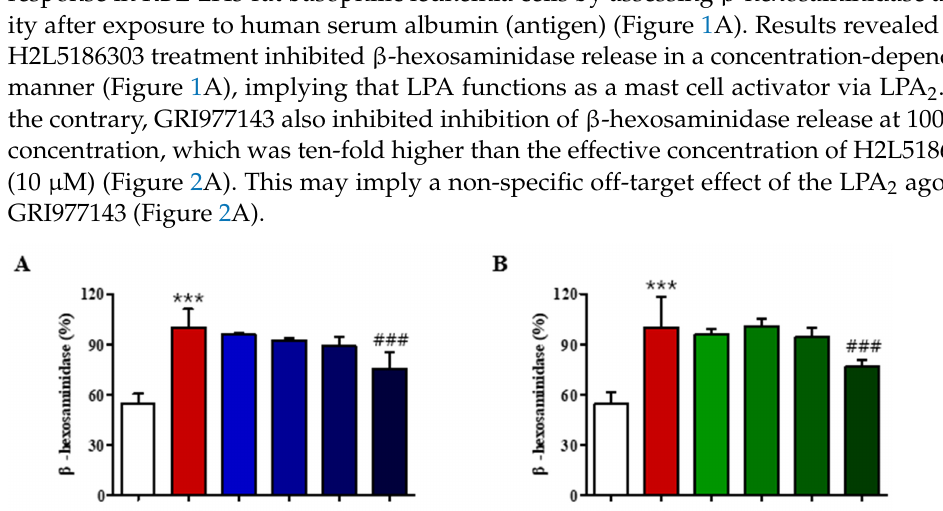
Figure 2. H2L5186303 and GRI977143 inhibit ovalbumin ‐ induced immune cell accumulation in BALF. ( A ) Mice were sensitized with ovalbumin (OVA) twice via intraperitoneal injection on days 0 (D0) and 14 (D14) and challenged on D28, D29, and D30 with nebulized OVA. H2L5186303 or GRI977143 was administered intraperitoneally at a dose of 1 mg/kg 30 min before OVA sensitization or challenge. BALF cells were stained with May–Grünwald stain and counted. ( B ) Total cell, mac ‐ rophage, and eosinophil counts in BALF. ( C ) Lymphocyte counts in BALF. The results are presented as mean ± standard error (SE) of the cell count values ( n = 5). *** p < 0.001 vs. the phosphate buffered saline ‐ treated group, # p < 0.05, ## p < 0.01 vs. the OVA ‐ treated group.